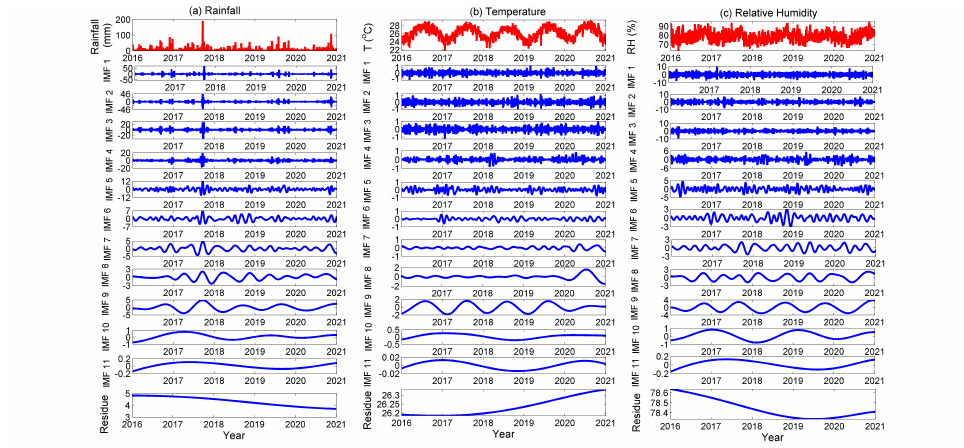
Figure 3. Results of the decomposition of different variables using the MEMD analysis for ( a ) rainfall ( R ); ( b ) temperature ( T ) and ( c ) relative humidity ( Rh ).